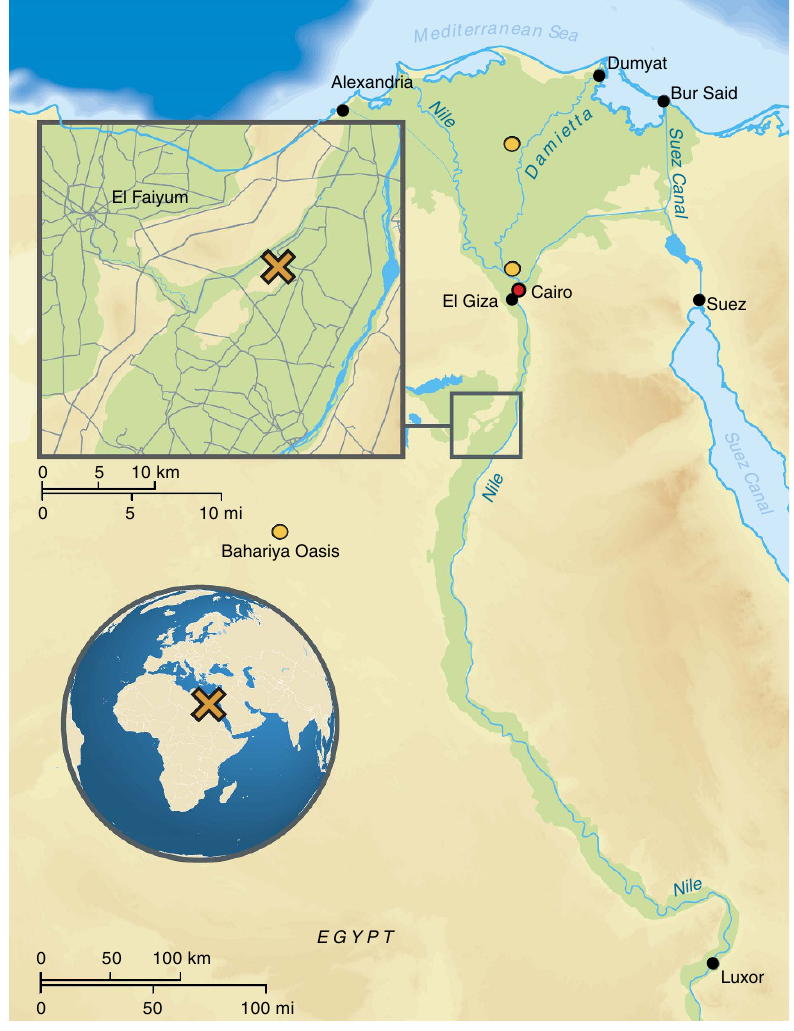
Figure 1 | Geographic context, of the samples used in this study. Map of Egypt depicting the location of the archaeological site Abusir-el Meleq (orange X) and the location of the modern Egyptian samples (orange circles) (design of the graphic by Annette For the DNA analysis we sampled different tissues (bone, soft sample, and 11- to 4,236-fold coverage. To estimate, identify and tissue, tooth), macerated and non-macerated, to test for human filter out potential contamination we applied the program DNA preservation. schmutzi 15 with strict criteria for contamination and kept only samples with less than 3% contamination for further analysis. For a comparison of different source material (soft tissue, bone and teeth) ten individuals (Supplementary Table 1) were sampled multiple times. Yields of preserved DNA were comparable in bone and teeth but up to ten times lower in soft tissues (Fig. 2a, Supplementary Table 1). Nucleotide misincorporation patterns characteristic for damaged ancient human DNA allowed us to assess the authenticity of the retrieved DNA 13,14 . The observed DNA damage patterns differed for the source materials with on average 19% damage in soft tissues and around 10% damage in bone tissue and teeth (Fig. 2b,c, Supplementary Table 1). Importantly, mtDNA haplo- types were identical for all samples from the same individuals. Our results thus suggest that DNA damage in Egyptian mummies correlates with tissue type. The protection of bone and teeth by the surrounding soft tissue or the embalmment of soft tissue may have contributed to the observed differences.